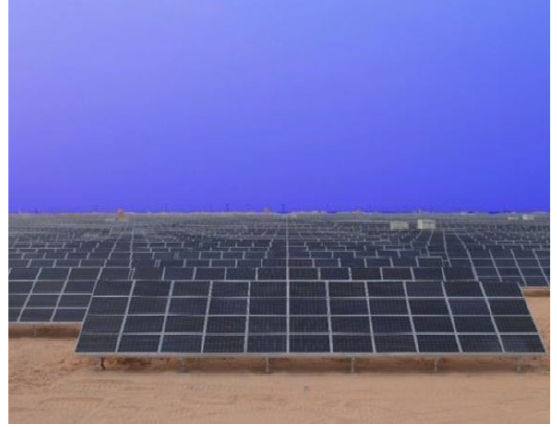
Figure 5. Panoramic photograph of the 20 MW PV power plant